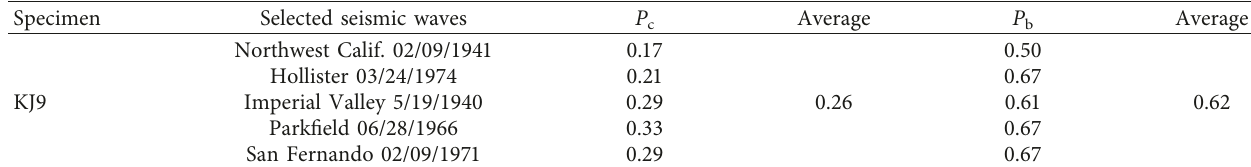
Table 21: Plastic hinge rates of beams and columns in model